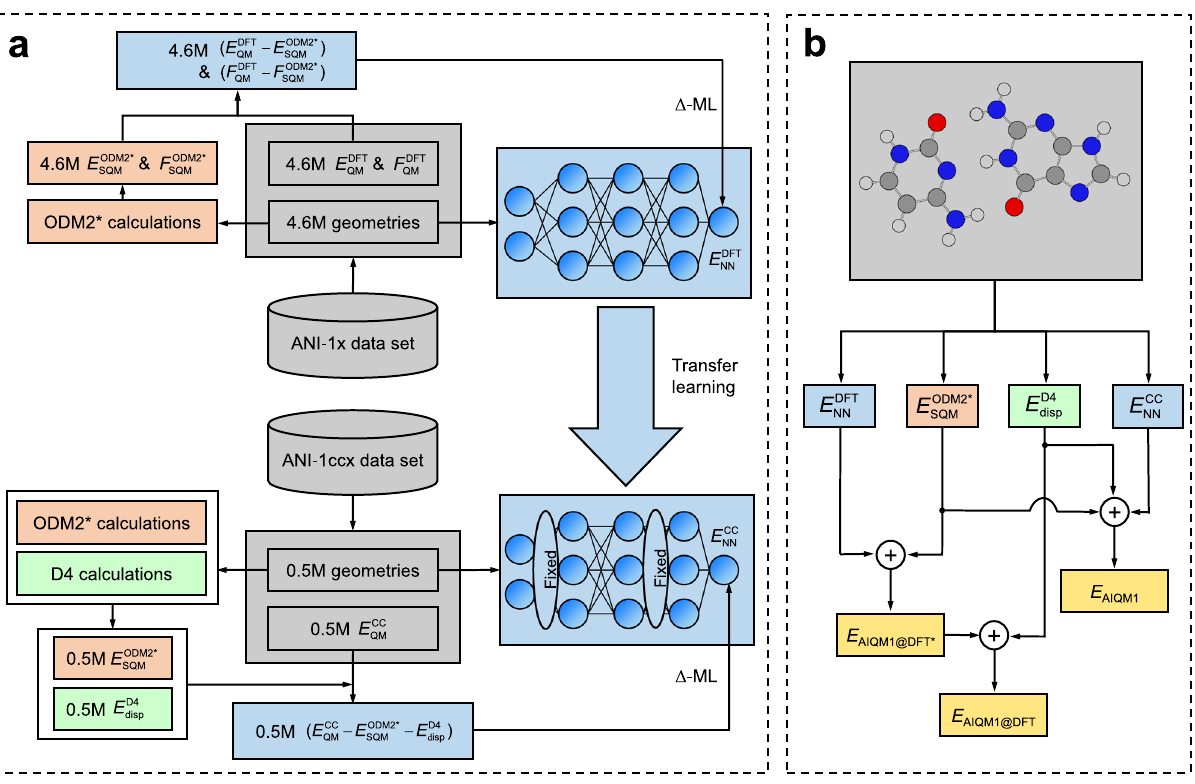
Fig. 2 The design of the arti fi cial intelligence – quantum mechanical method 1 (AIQM1). a Flowchart of training the neural network (NN) part of the AIQM1, AIQM1@DFT*, and AIQM1@DFT methods. b Schematic representation of the components of the AIQM1, AIQM1@DFT*, and AIQM1@DFT methods (yellow). DFT denotes density functional theory data at ω B97X/def2-TZVPP, CC — approximation to coupled cluster with single, double, and perturbative triple excitations with complete basis set extrapolation scheme (CCSD(T)*/CBS), E energies, F forces, ODM2* — semiempirical quantum mechanical (SQM) orthogonalization- and dispersion-corrected method 2 (light brown), D4 — the fourth generation of dispersion (subscript disp) corrections (green), NN – neural networks of ANI-type (blue; corrections to learn also blue). Molecular data sets are in